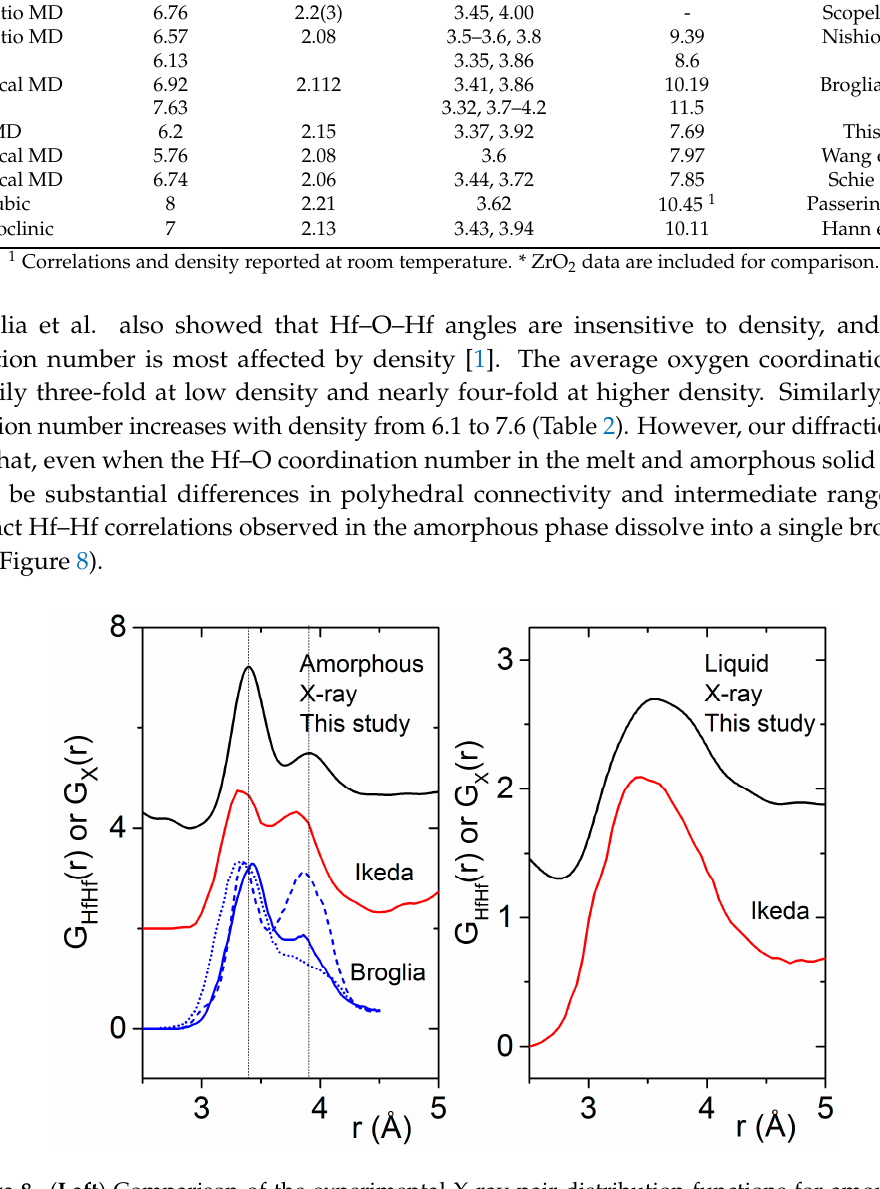
Figure 8. ( Left ) Comparison of the experimental X-ray pair distribution functions for amorphous HfO 2 (black) with DFT simulations of the Hf–Hf partial pair distribution function taken from the literature [1,8]. Densities of 8.6, 10.19, and 11.5 g ∙ cm − 3 are denoted by blue dashed, solid, and dotted lines respectively. ( Right ) The same comparison made for liquid HfO 2 .